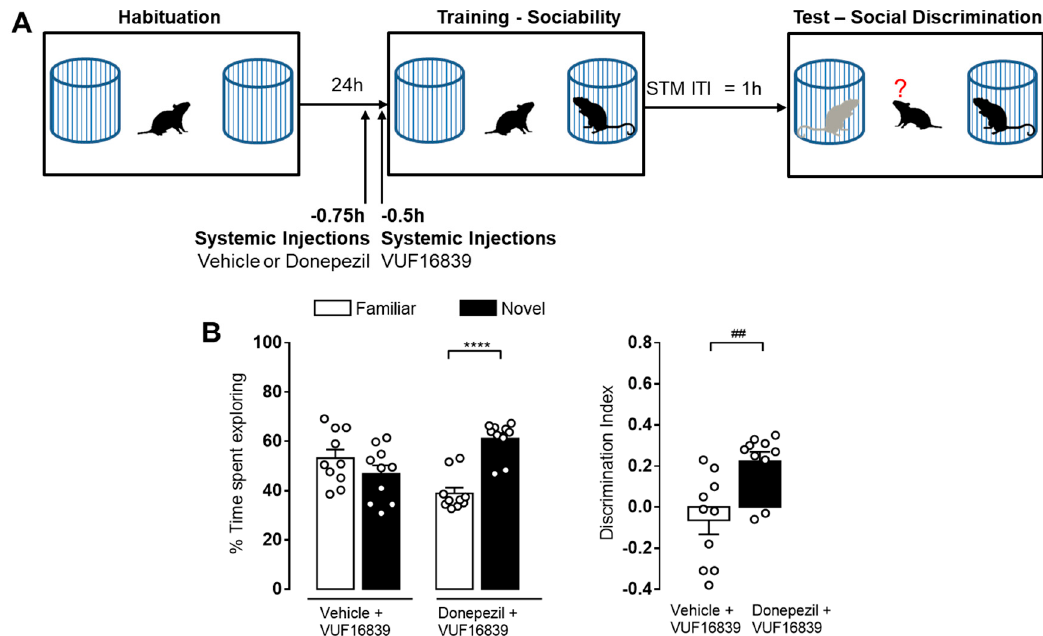
Figure 5. H 3 R agonist-induced amnesic effect does not require histaminergic neurotransmission. ( A ) Schematic drawing showing the sequence of the behavioral procedures. VUF16839 (5 mg/kg, i.p.) or vehicle were injected to Hdc − / − ( B ) or α FMH treated mice ( C ) 0.5 h before training. Retention tests were performed 1 h after training. Shown are means ± S.E.M. of 8–10 animals per experimental group. *** p < 0.001 by two-way ANOVA and Bonferroni’s MCT; # p < 0.05 by unpaired t -test.